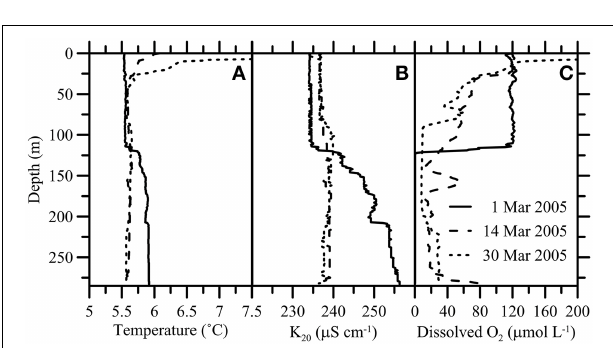
FIGURE 3 | Hydrocast sensor profiles of (A) temperature, (B) conductivity ( K 20 ), and (C) dissolved O 2 concentrations during the first mixing event in March 2005. Changes in hypolimnetic water temperature and electrical conductivity indicate convective mixing of the complete water column in March 2005. Deep-water renewal is also indicated by the occurrence of traces of O 2 at the bottom of the